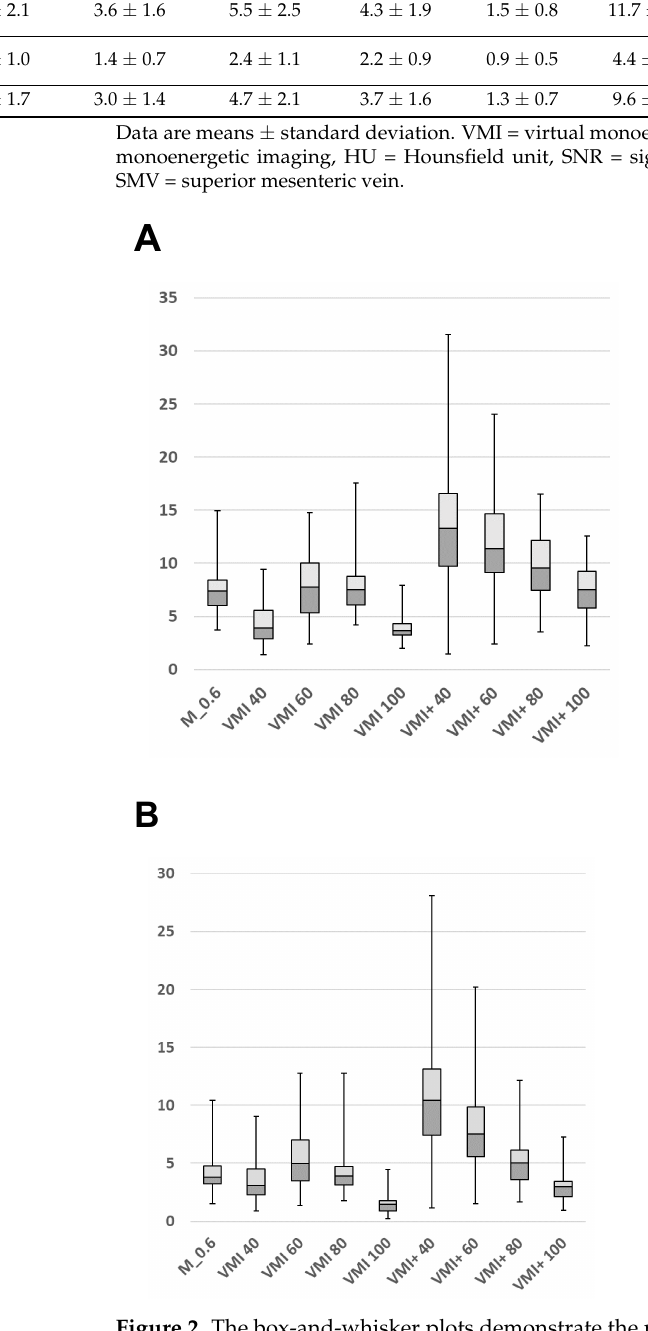
Figure 2. The box-and-whisker plots demonstrate the results of the quantitative image analysis (vari- ables are presented as means ± SD). Signal-to-noise (SNR, A ) and contrast-to-noise ratios (CNR, B ) in the portal vein were compared between linearly blended M_0.6, standard virtual monoenergetic imaging (VMI), and noise-optimized VMI+ series at different keV levels.